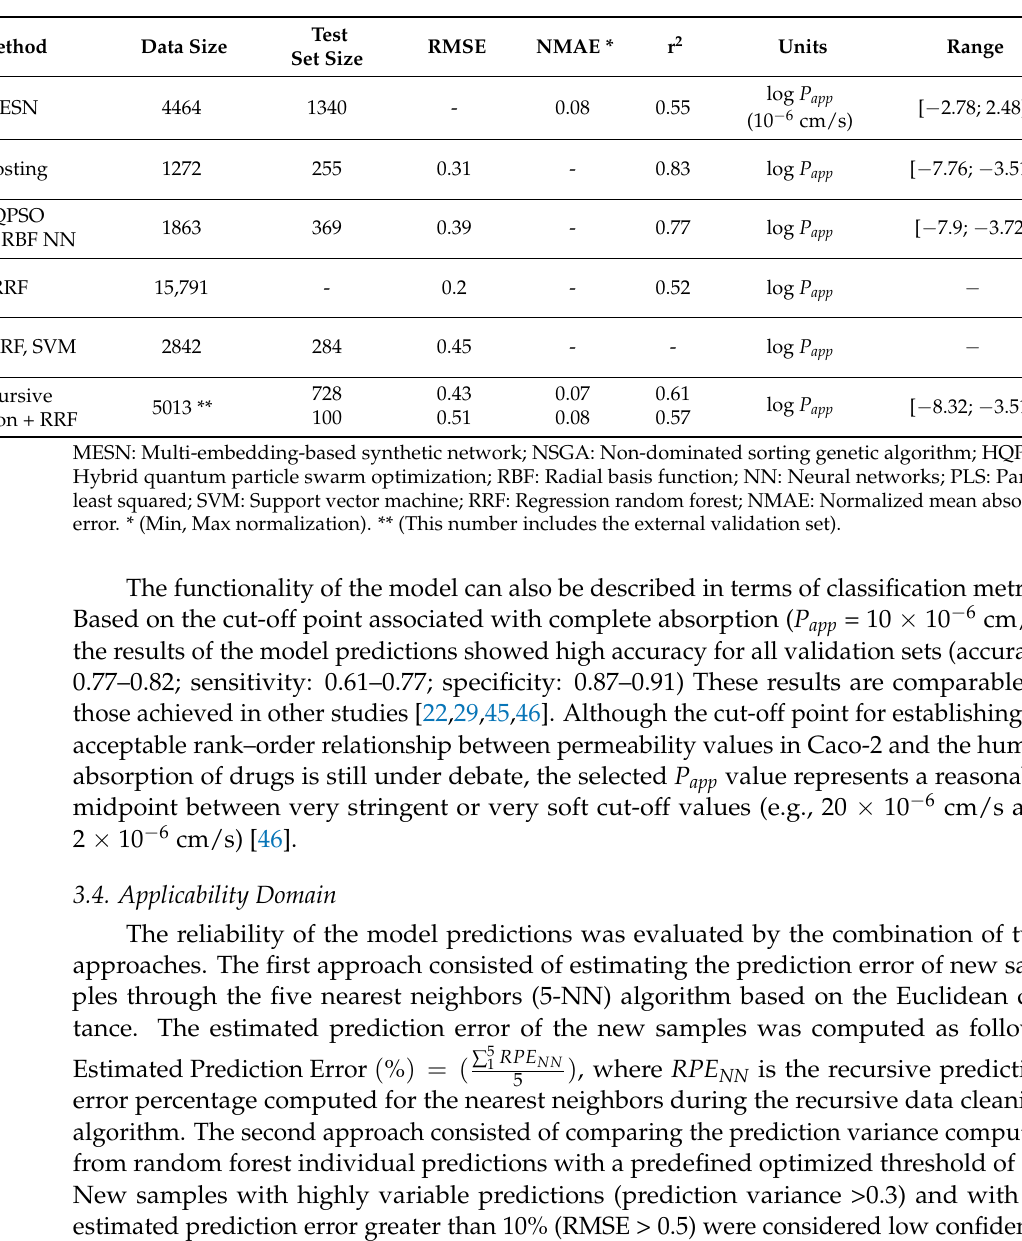
Table 2. Comparison between the current model and previous QSPR